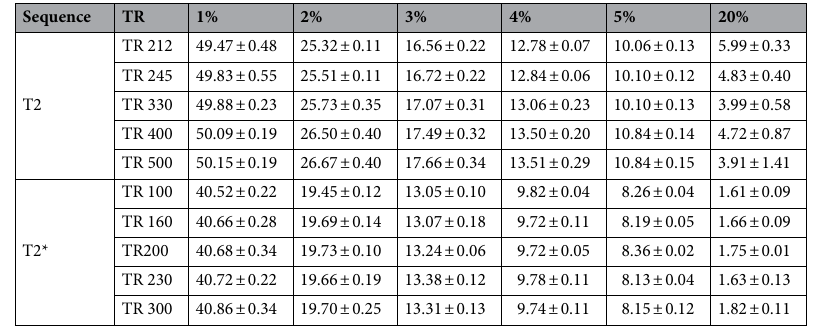
Table 4. Phantom mean measurements ± standard deviation of different TR using T2 and T2* sequences.